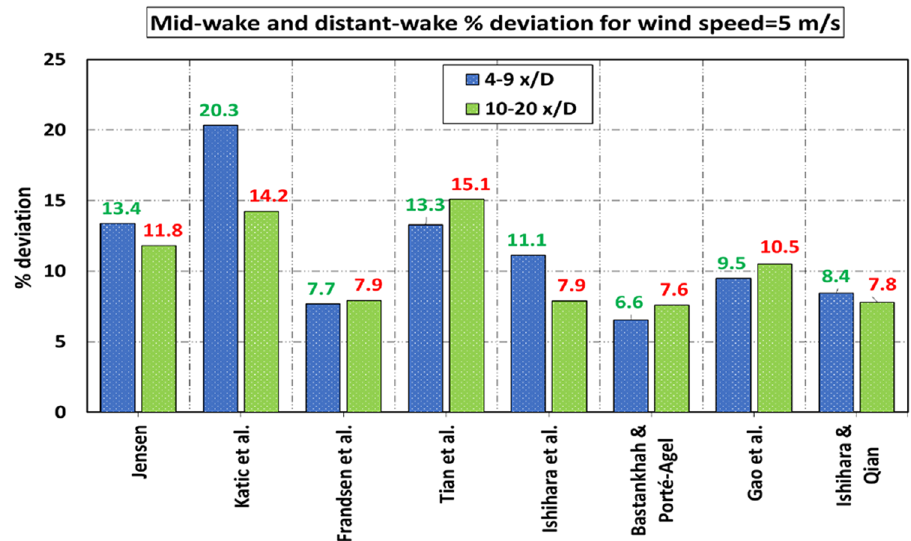
Fig. 5. Average percentage deviation of each wake model for upstream wind speed value equal to 5m/s.